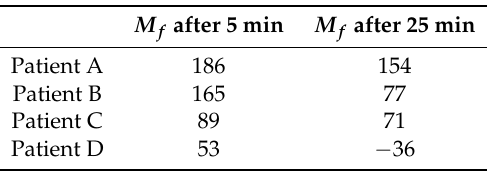
Table 2. Measured M f for the 4 persons tested.